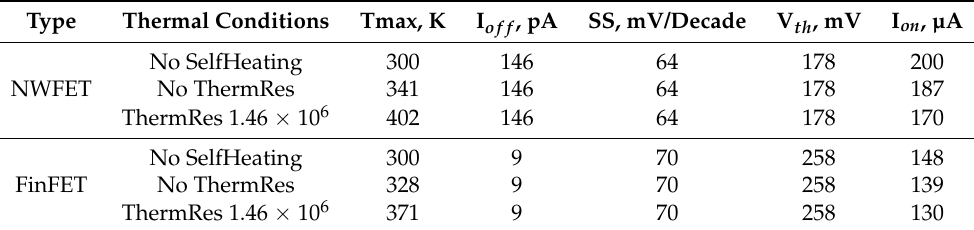
Table 4. The effect of overheating on the main parameters of transistors.